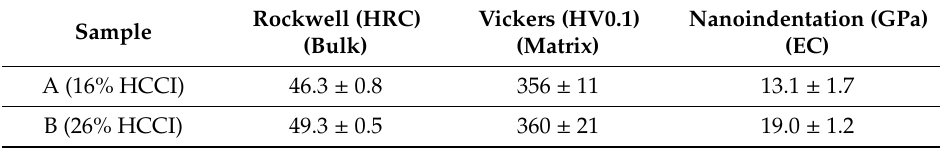
Table 6. Results of the bulk, matrix and carbide hardness for both